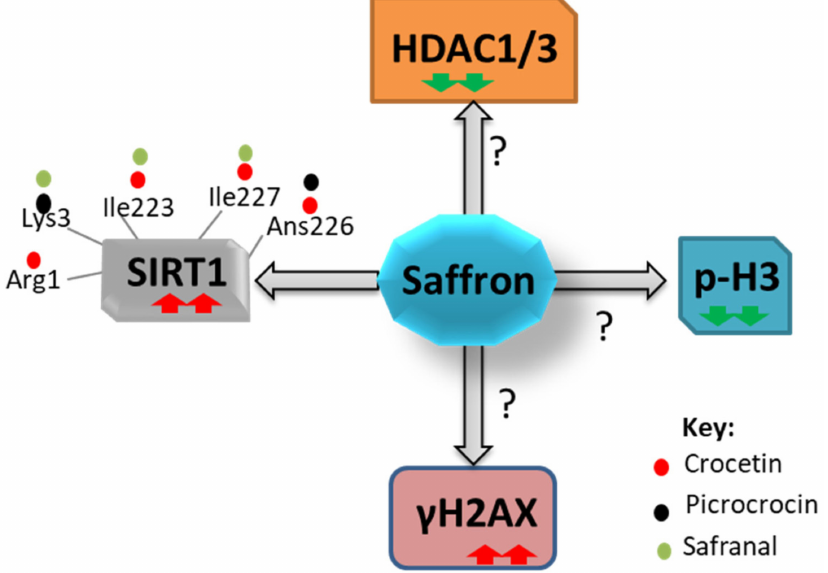
Figure 2. Modulation of epigenetic factors upon treatment with saffron. Saffron interacts with SIRT1 at different residues and augments its activity; also, saffron alters the expression of HDAC1/3, pan-H3 phosphorylation (p-H3), and γ H2AX by an unknown mechanism. Red arrow depicts high, and the green represents low levels of